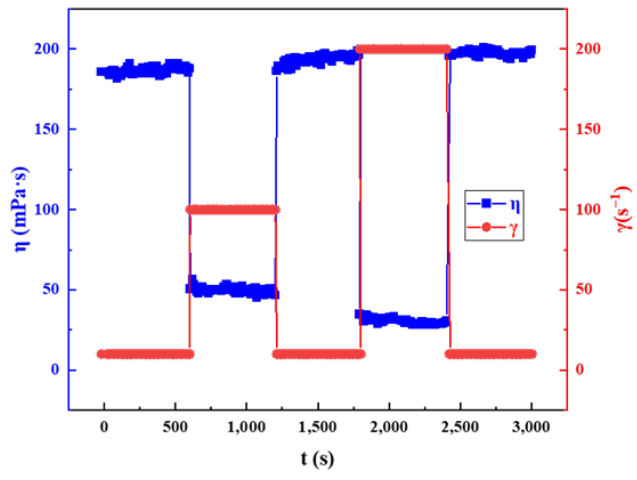
Figure 10. Shear recovery of GOHAC/NaPts gel solution.